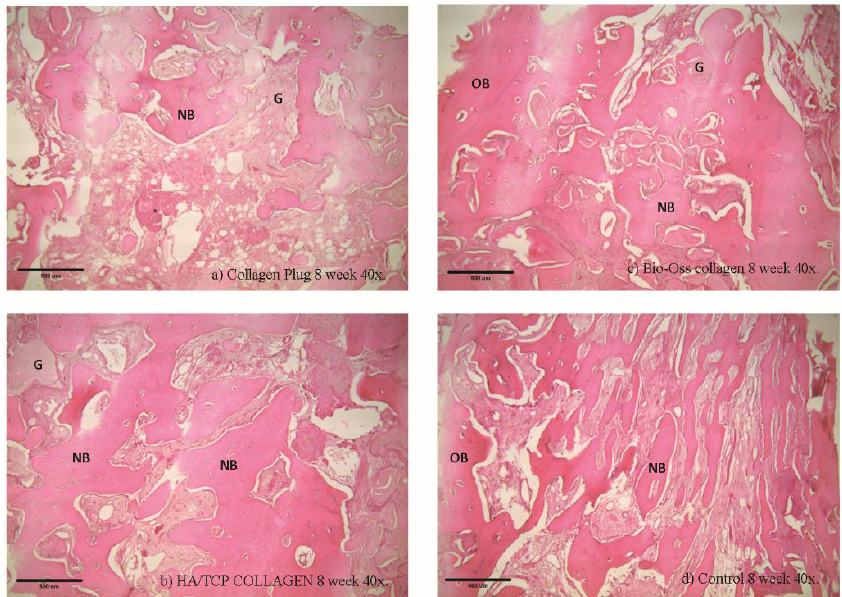
Figure 7. Histological examination at the eight week using 40× magnification. Histological analysis of the collagen ( a ), bovine xenograft-collagen composite ( b ), hydroxyapatite/β-tricalcium phosphate (HA/β-TCP)-collagen composite ( c ) and control groups ( d ). Hematoxylin and eosin staining; original magnification: 40×. Abbreviations: NB, newly-formed bone; OB, old bone; G, granule residual.